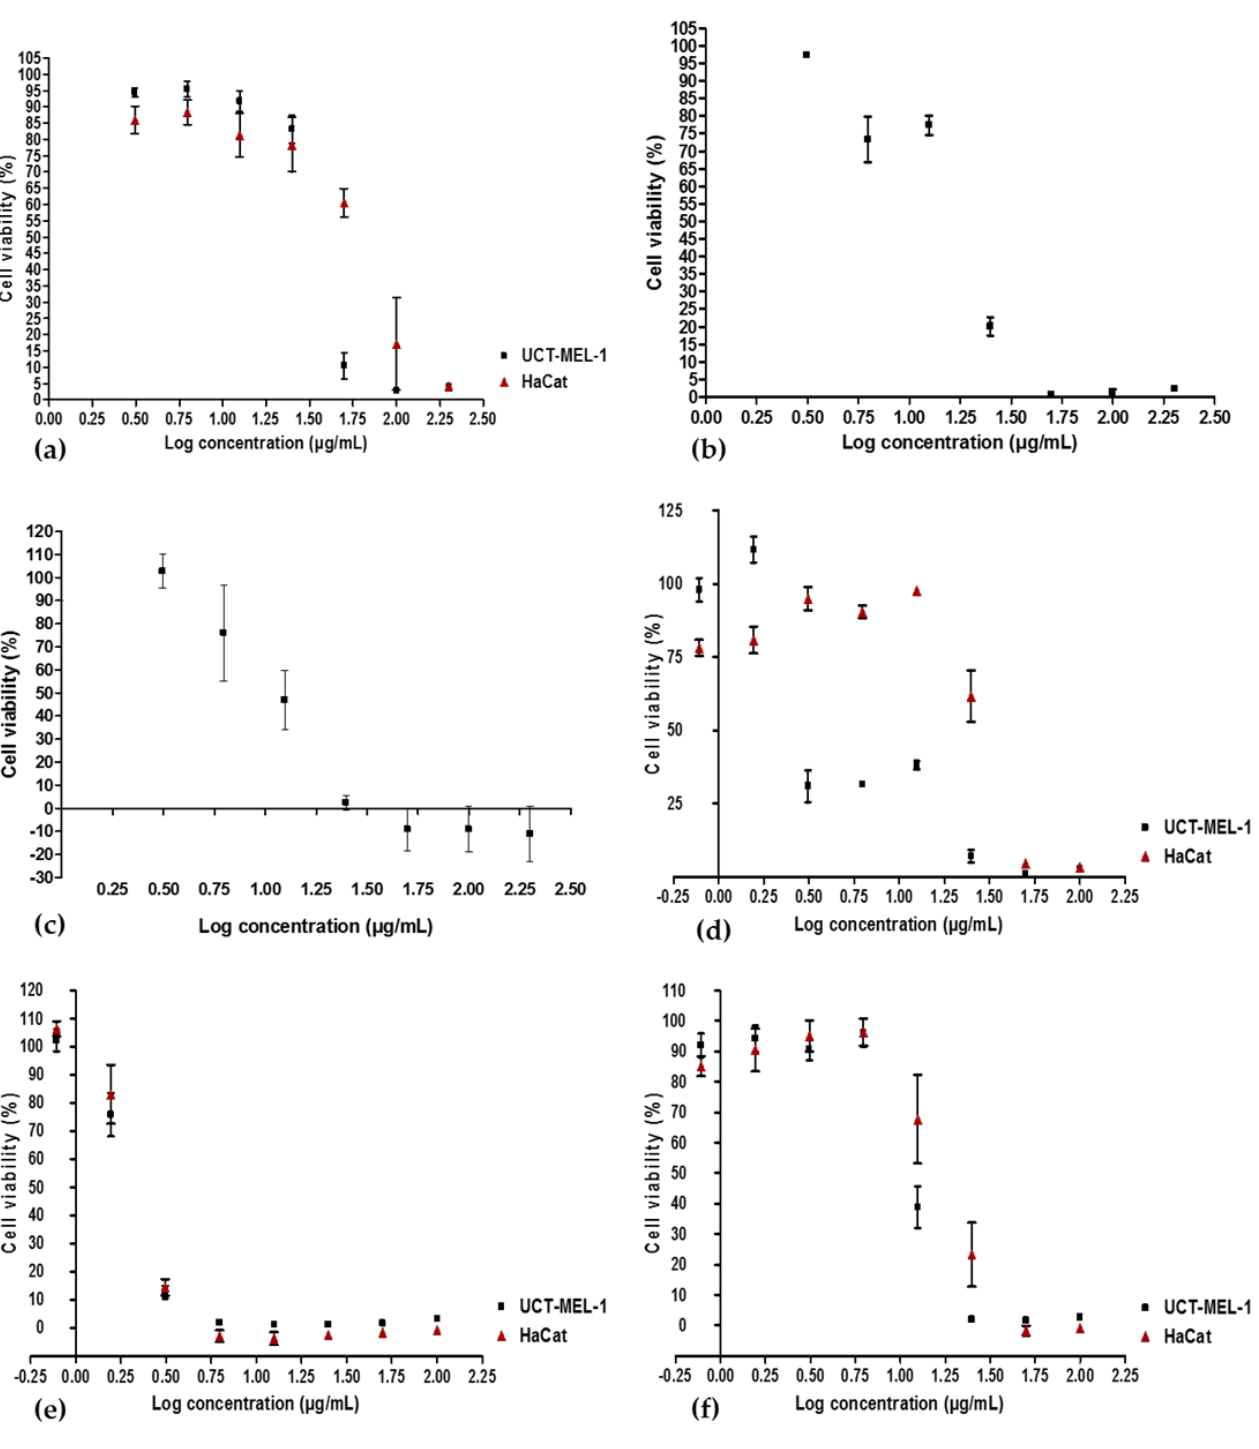
Figure 3. Dose—response curves depicting the antiproliferative activity of ( a ) Buddleja saligna ethano- lic extract, ( b ) dichloromethane partition, ( c ) M4 major fraction, ( d ) DT-BS-01 triterpenoid mixture, ( e ) ursolic acid and ( f ) oleanolic acid against human malignant melanoma (UCT-MEL-1) cells and human keratinocytes (HaCat). Data shown are mean ± SEM ( n = 3).